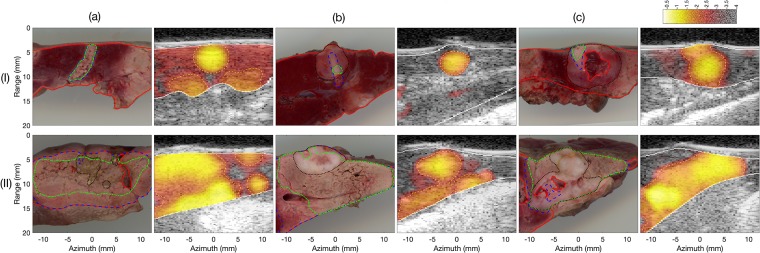
Histologic and hybrid B-mode/echo decorrelation for HIFU and bulk US controlled trials.In the tissue sections, the red, black, blue, and green boundaries indicate the segmented tissue, tumor, treated, and fully ablated regions. In the US images, the white line indicates segmented tissue boundaries and the yellow dashed line represents the optimum prediction threshold for local tissue ablation for all US exposures of both groups.